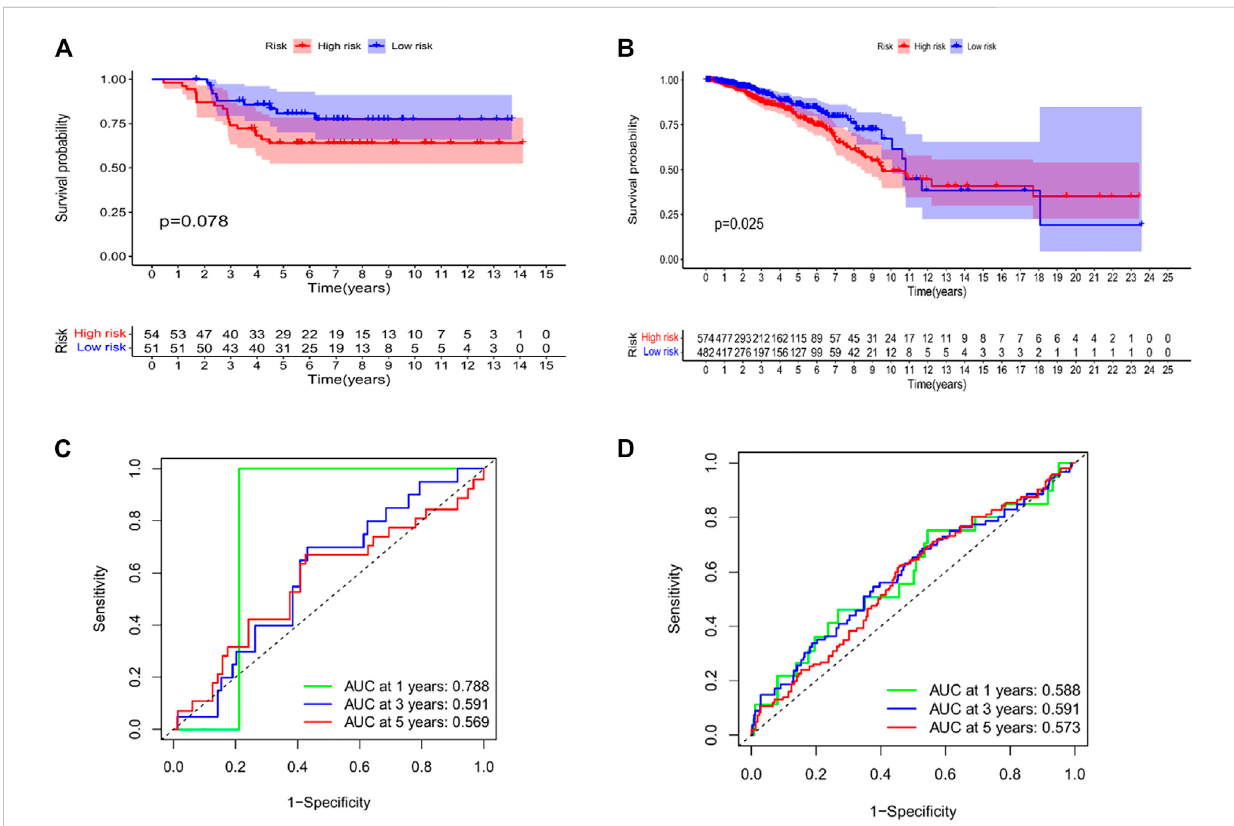
FIGURE 8 Validation of the risk model in the testing datasets. (A) KM curves for the OS of patients in the high- and low-risk groups in the 2 mRNAs-related prognostic model (GSE58812). (B) KM curves for the OS of patients in the high- and low-risk groups in the 2 miRNAs-related prognostic model (TCGA- BRCA). (C) Time-dependent ROC curve analysis of the 2 mRNAs-related prognostic for predicting 1-, 3-, 5-year OS (GSE58812). (D) Time-dependent ROC curve analysis of the 2 miRNAs-related prognostic for predicting 1-, 3-, 5-year OS